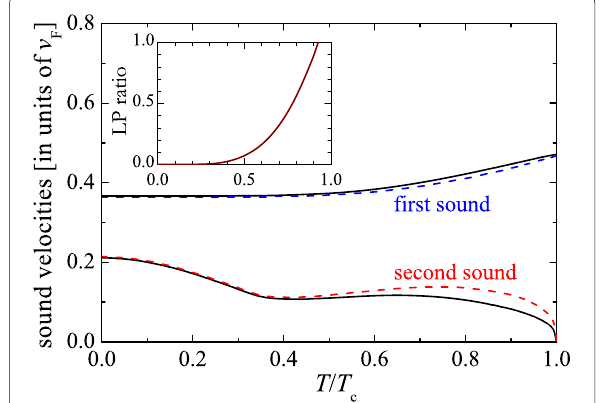
Fig. 4 First and second sound velocities of a uniform Fermi gas at unitarity (solid lines), predicted by the GPF theory. The units of the velocity is v F = (cid:2) k F / m . The uncoupled first and second sound velocities given by v S and v are shown as dashed and dotted lines, respectively. The inset shows the Landau-Placzek ratio as a function of T / T c . From Ref.